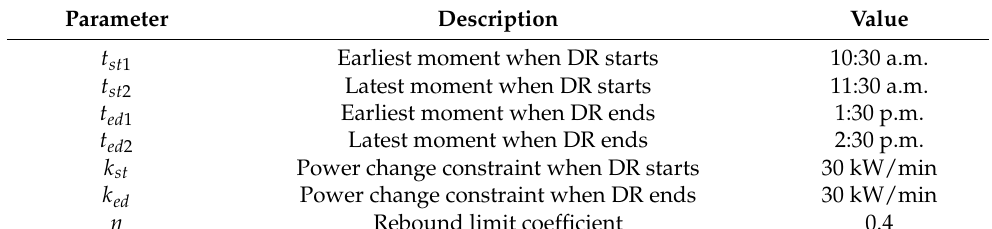
Table 3. Main parameters of the temperature-queuing method.